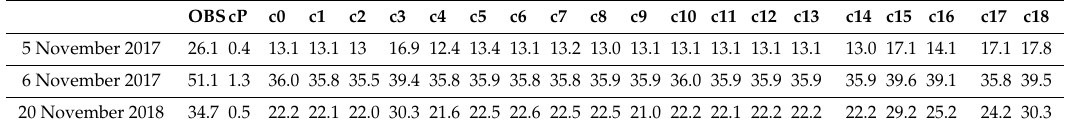
Table 8. Daily precipitation values (mm) averaged over the network of ANCE (Associazione Nazionale Costruttori Edili) stations, for observational and model data (all configurations). Maximum deviation (cP) from the reference simulation with the initial condition ensemble.